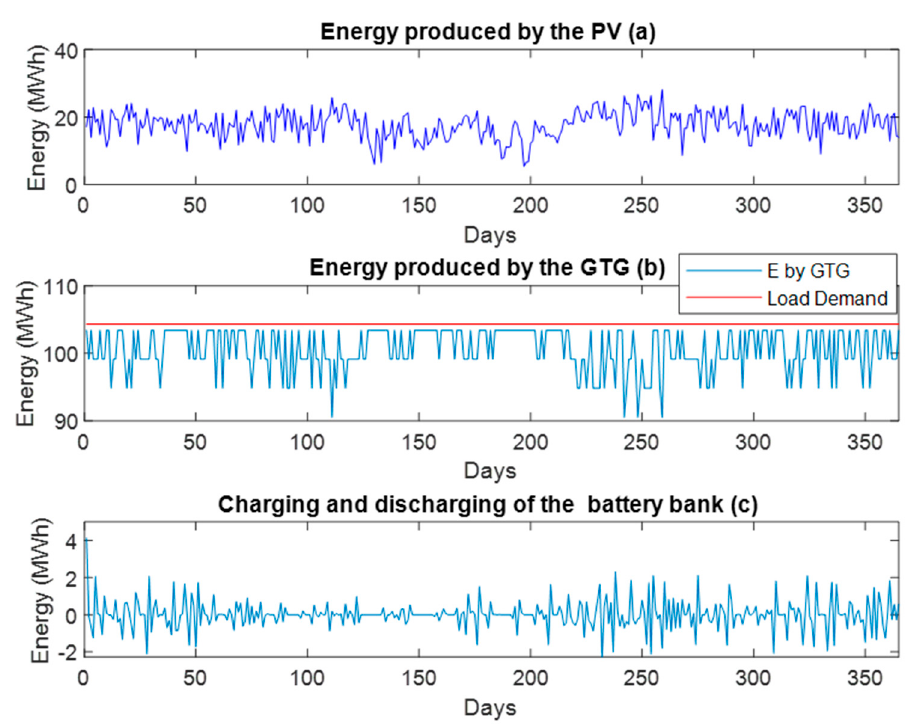
Figure 8. Energy production, ( a ) energy produced by PV array ( b ) energy produced GTG; ( c ) Battery charging and discharging energy.